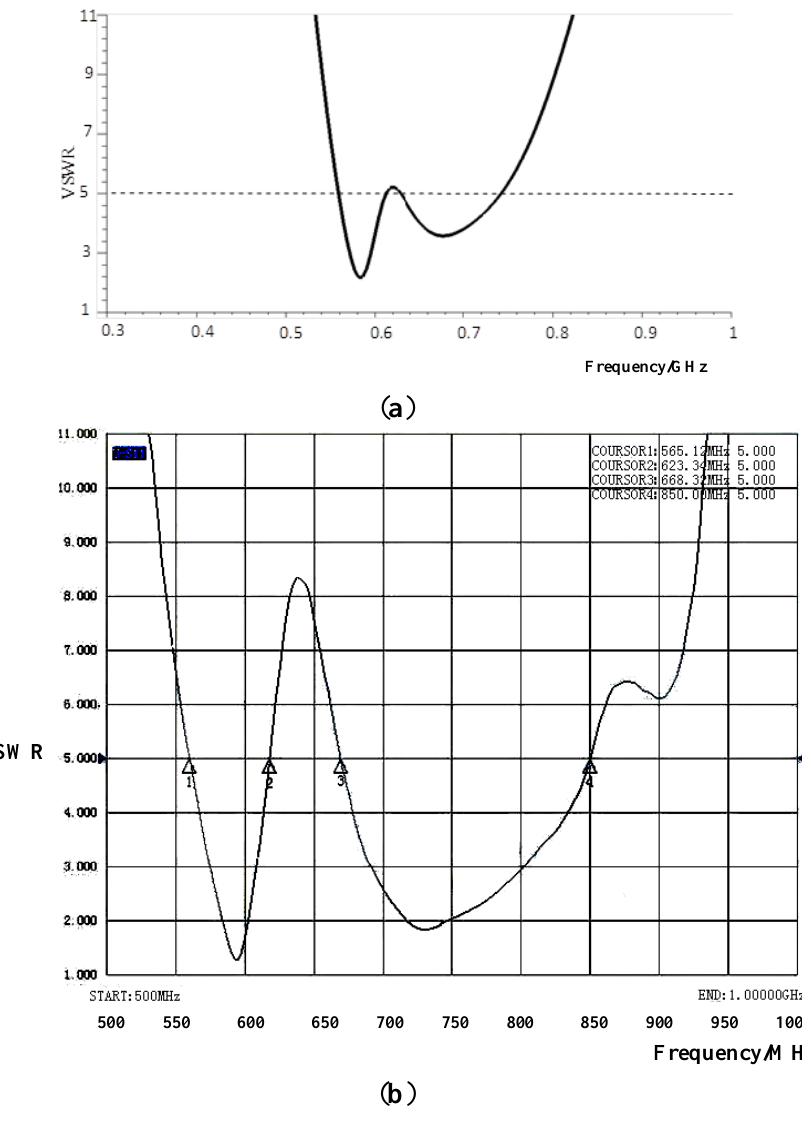
Figure 5. VSWR curve of the designed antenna. ( a ) VSWR curve in HFSS, ( b ) Measured VSWR